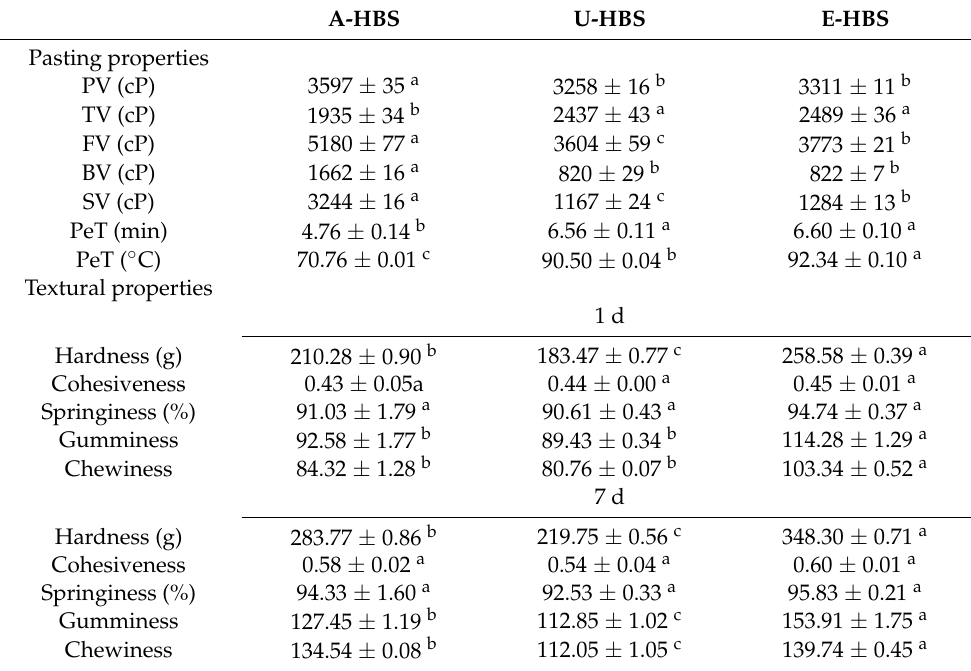
Table 2. Pasting and textural properties of highland barley starch